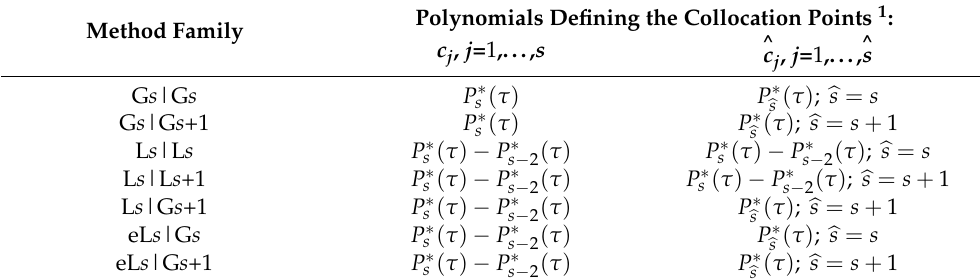
Table 1. The proposed method